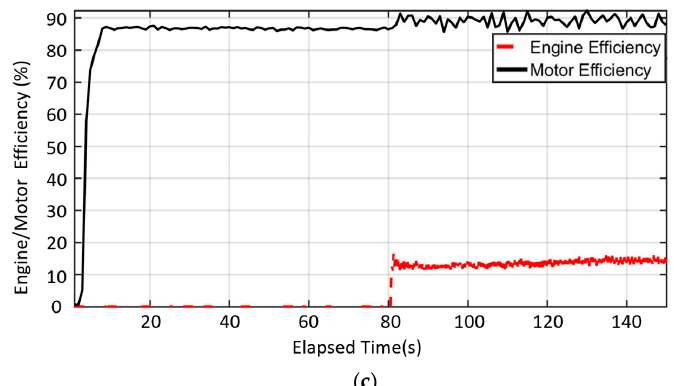
Figure 11. Engine / hub motor hybrid mode: ( a ) input power; ( b ) output power; and, ( c ) e ffi ciency.